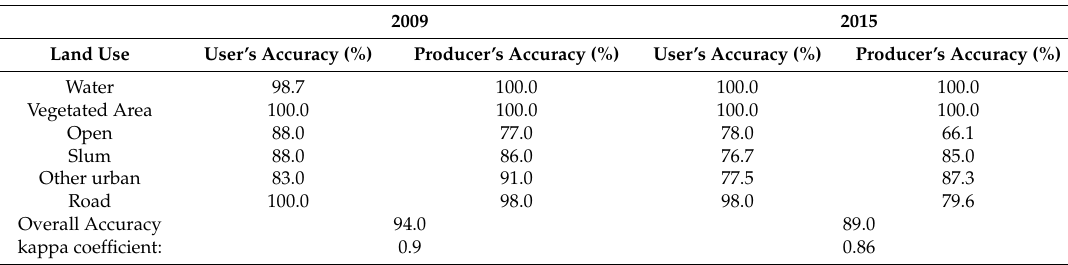
Table 6. Summary of LULC map accuracies (%) for 2009 and